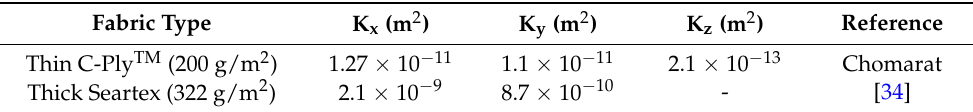
Table 3. Permeability values (V f = 51%–52%) for thick and thin